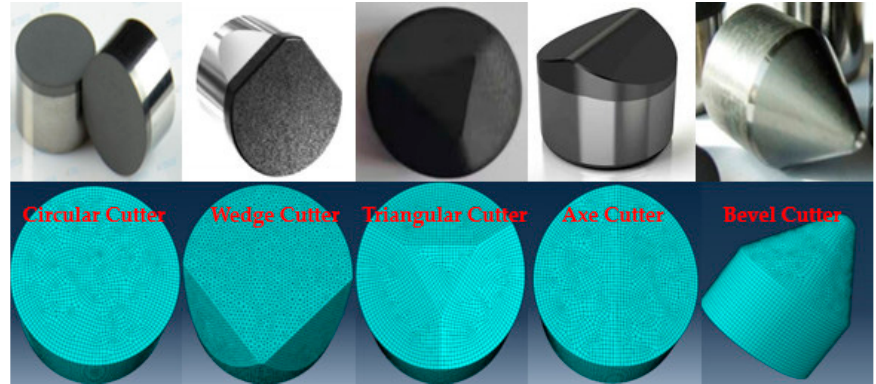
Figure 3. Shaped cutter and its model establishment.